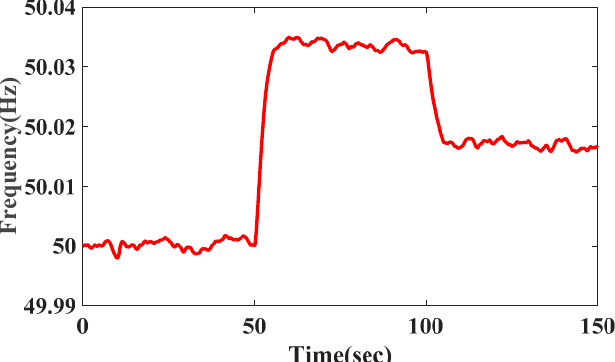
Energies 2017 , 10 , 1797 Figure 18. Frequency response when the wind speed change suddenly. Figure 18. Frequency response when the wind speed change suddenly.